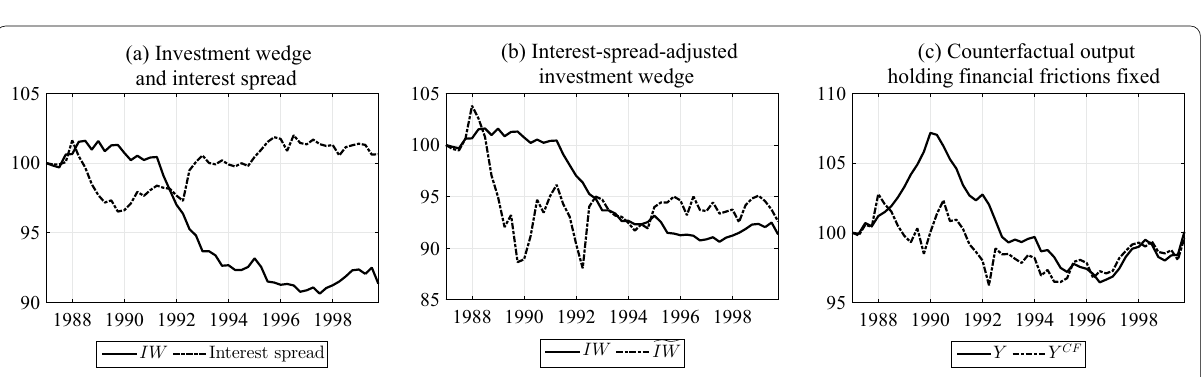
Fig. 23 Robustness: The role of disruptions in financial intermediation for µ = 0.36 (1987Q1–1999Q4). IW denotes the investment wedge, the interest spread corresponds to the spread between the lending and deposit rates obtained from the IMF International Financial Statistics, and is the interest-spread-adjusted investment wedge. Y is output and Y CF denotes the counterfactual path of output when holding financial frictions